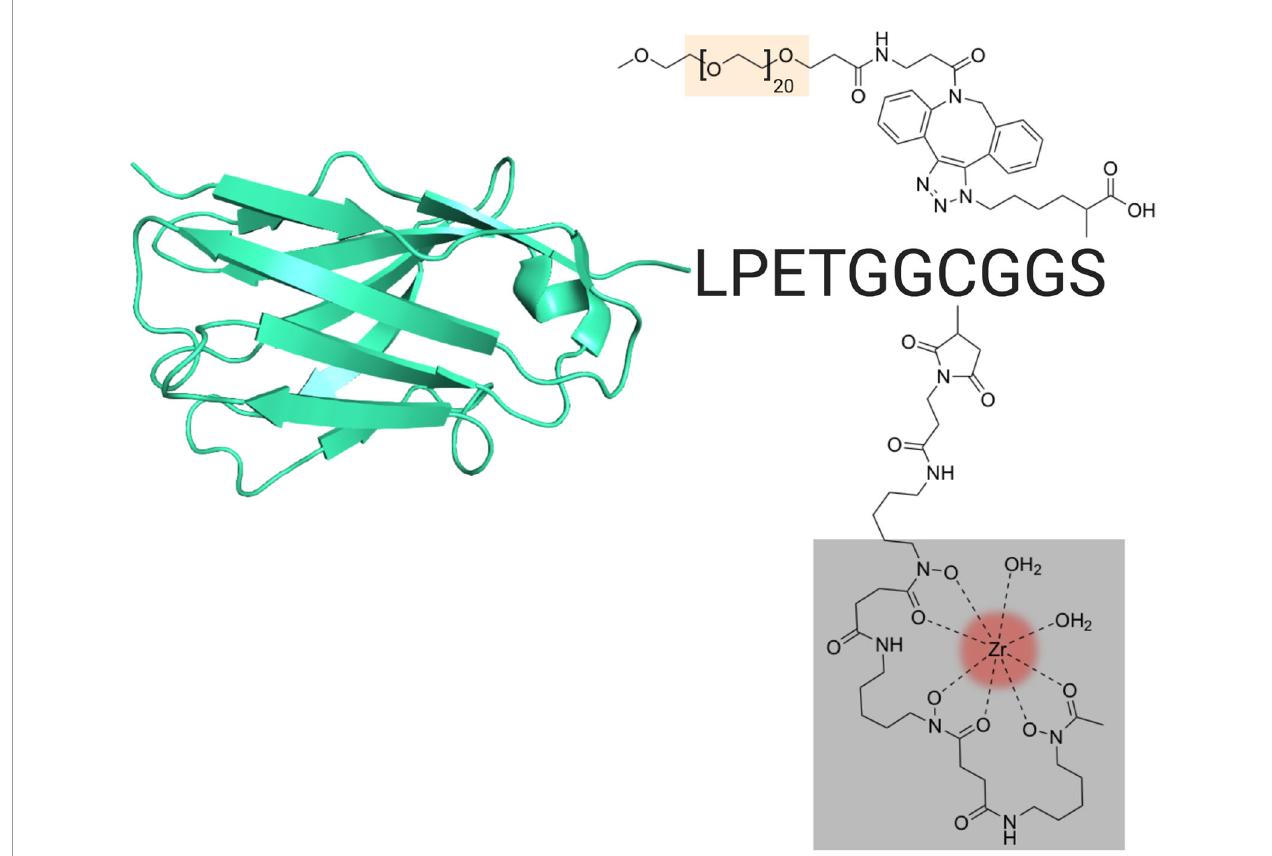
FIGURE 1 | VHH Construct and Design. Schematic of the VHH-X118 construct used to track CD8 + T cells in vivo . A representative VHH structure (PDB: 3OGO) is shown covalently bound to the peptide probe LPETGGCGGS. Maleimido-DFO (grey), which was covalently linked to the peptide probe at the cysteine thiol, is shown chelating 89 Zr (red). A terminal, azide-substituted lysine was covalently modi fi ed with a PEG 20 substrate (peach) for improved